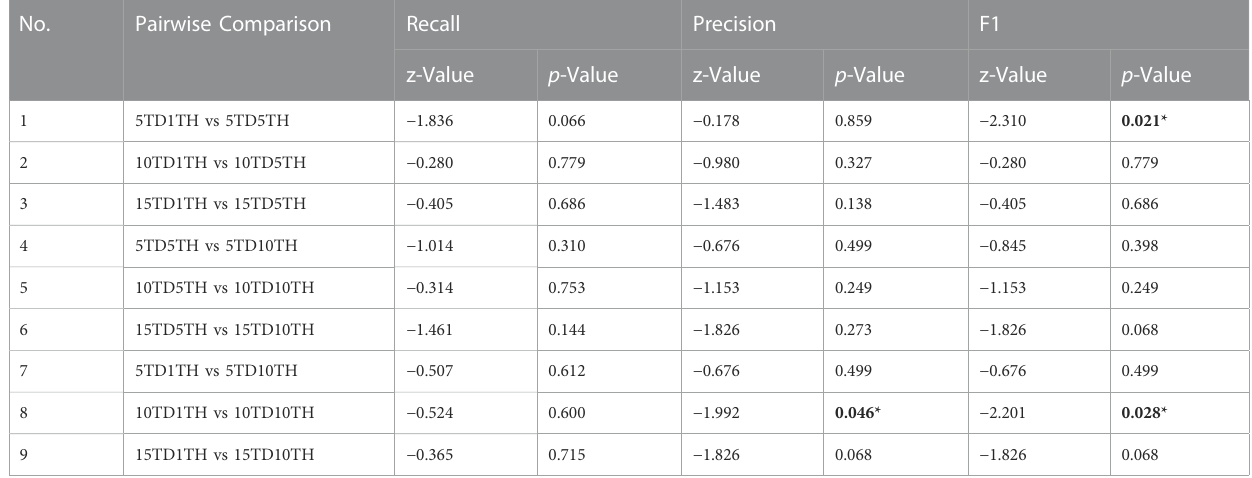
TABLE 5 Performance of different models by Wilcoxon signed-rank test. No.